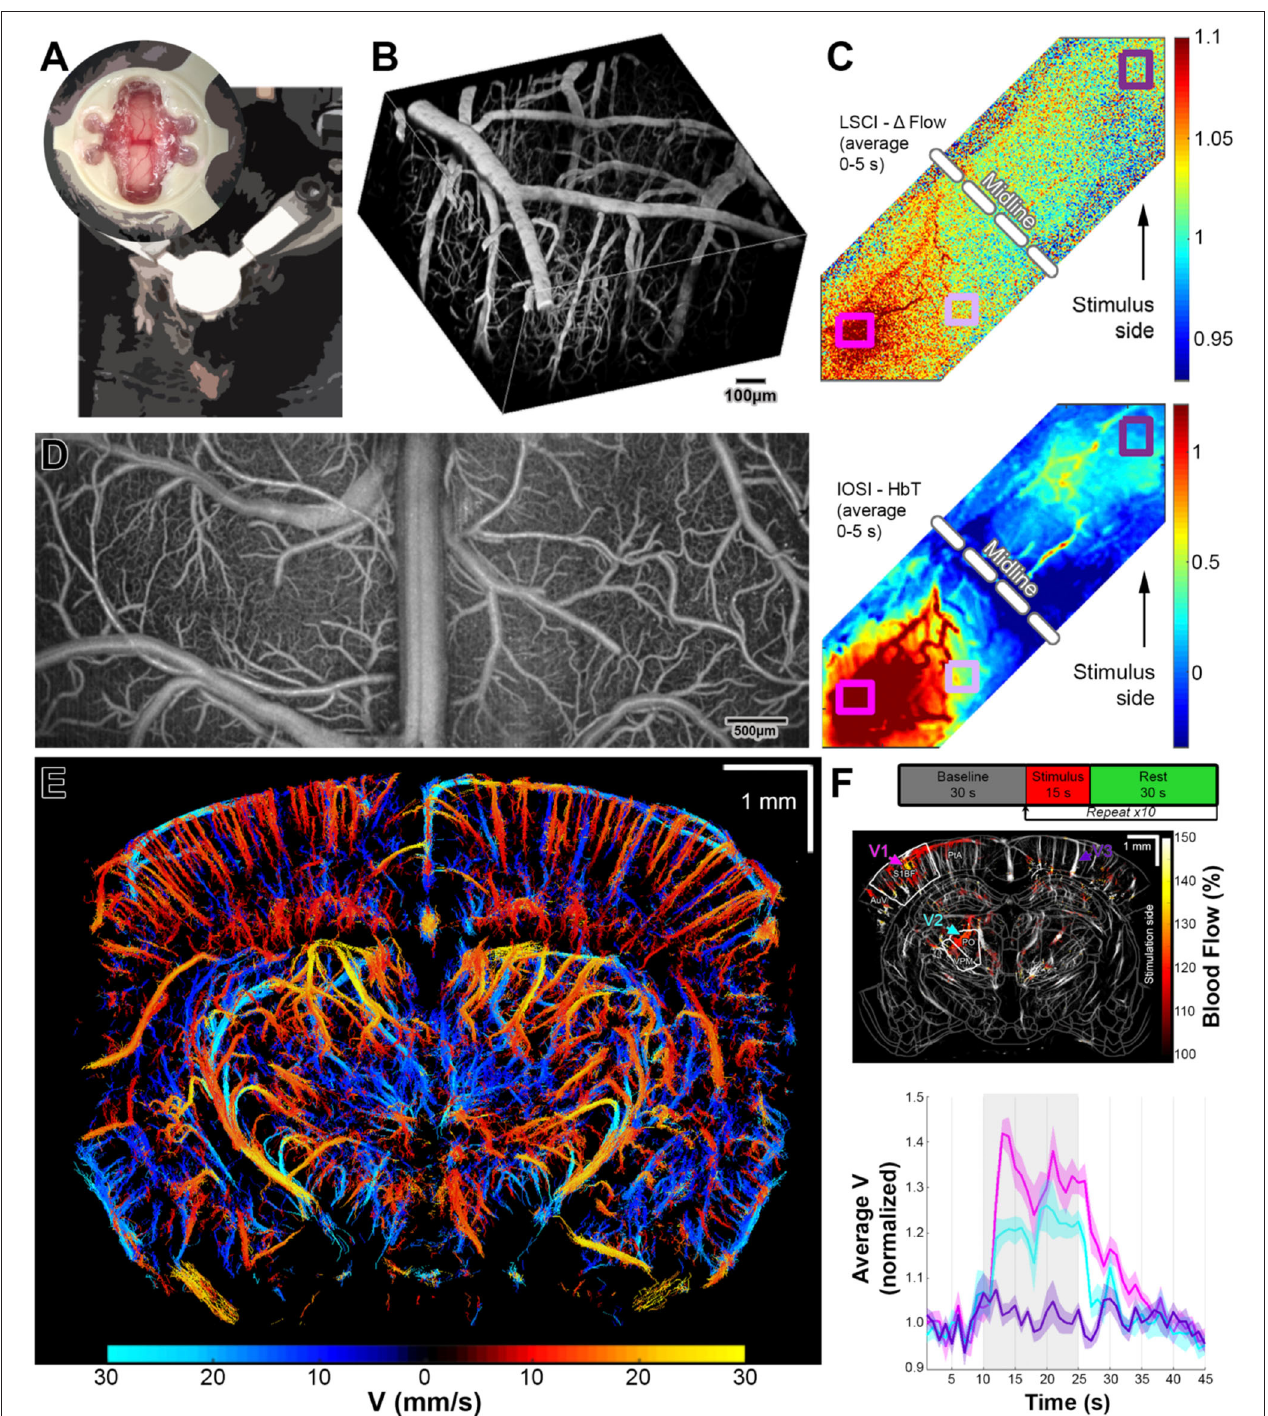
FIGURE 3 | (A) Representative images of US compatible craniotomy (top) and the position of an awake mouse for training and imaging. In this preparation, animal was implanted with a two-point secured machined head bar and a PMP strip (please see Supplementary Material for details). (B) 2-P vascular stack taken with i.v. FITC injection. The resolution for presented images was ∼ 1.5 µ m/pixel. (C) LSCI (top) and IOSI (bottom) of both hemispheres during whisker stimulation. The resolution for presented images was 5.5 µ m/pixel. (D) Full field OCT angiography. Transverse and axial resolutions of the OCT system using a 5 × objective (Mitutoyo) were 7 and 3.5 µ m. (E) ULM images acquired by US. The resolution for presented images was ∼ 10 µ m/pixel. (F) Experimental paradigm for fUS imaging (top). Trial average of fUS images acquired during whisker stimuli (middle). The resolution for presented images was ∼ 100 µ m/pixel. Time series of average velocity values calculated for marked vessels (middle) during whisker stimuli. Note that contralateral cortical and subcortical activation is visible while ipsilateral cortex is not activated. Modified from Tang et al. (2020).